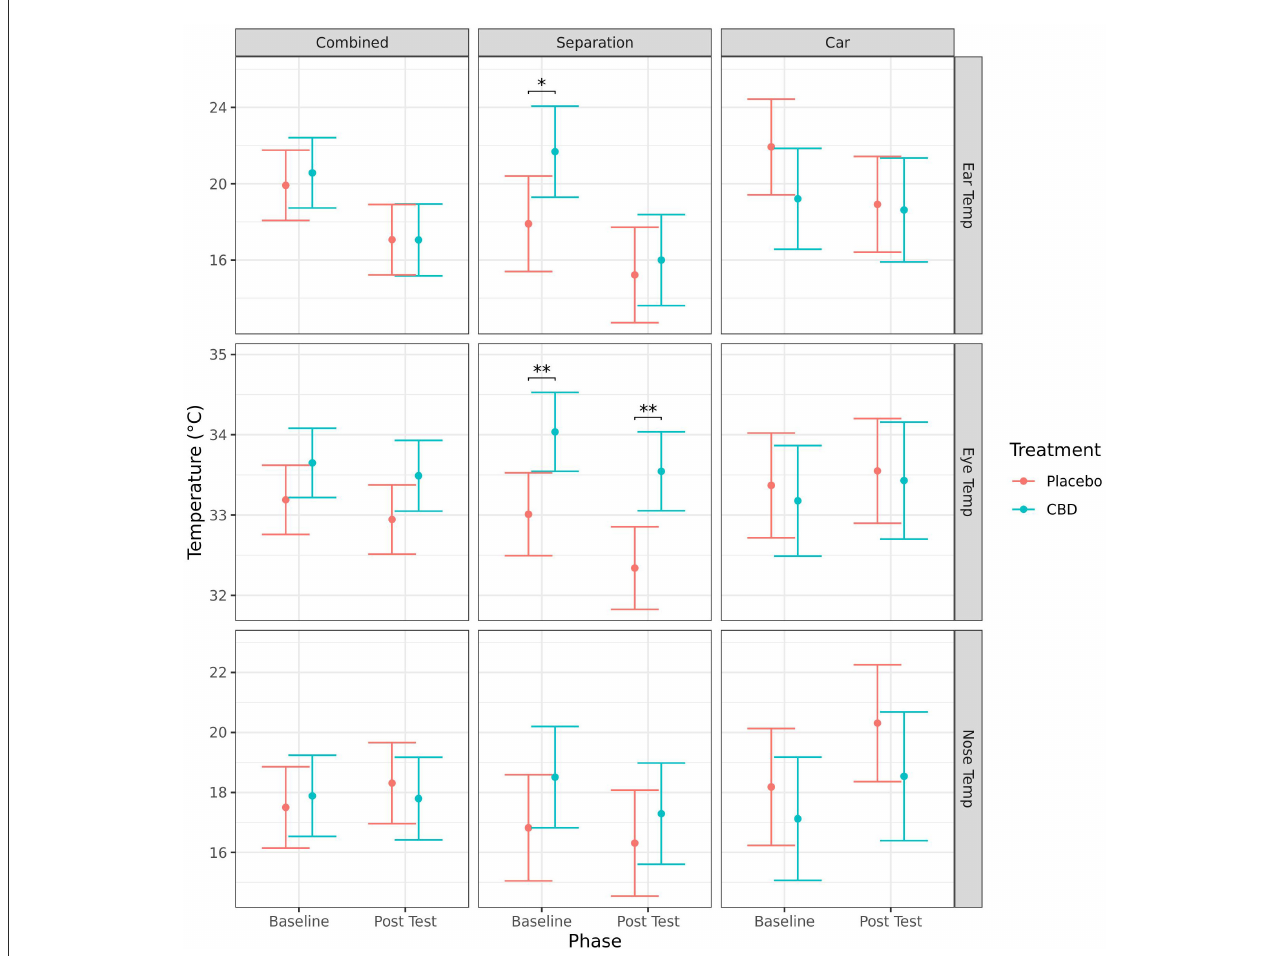
FIGURE4 Predicted mean (95% CI) ear, eye and nose temperature ( ◦ C) measured using infra-red thermography for dogs given CBD or placebo at each phase of testing (baseline and post-stressor) based on models analyzing both stress tests combined, separation test or car test. Asterisks indicate significant differences between treatment groups within each phase. ** p < 0.01, and * p < 0.05.